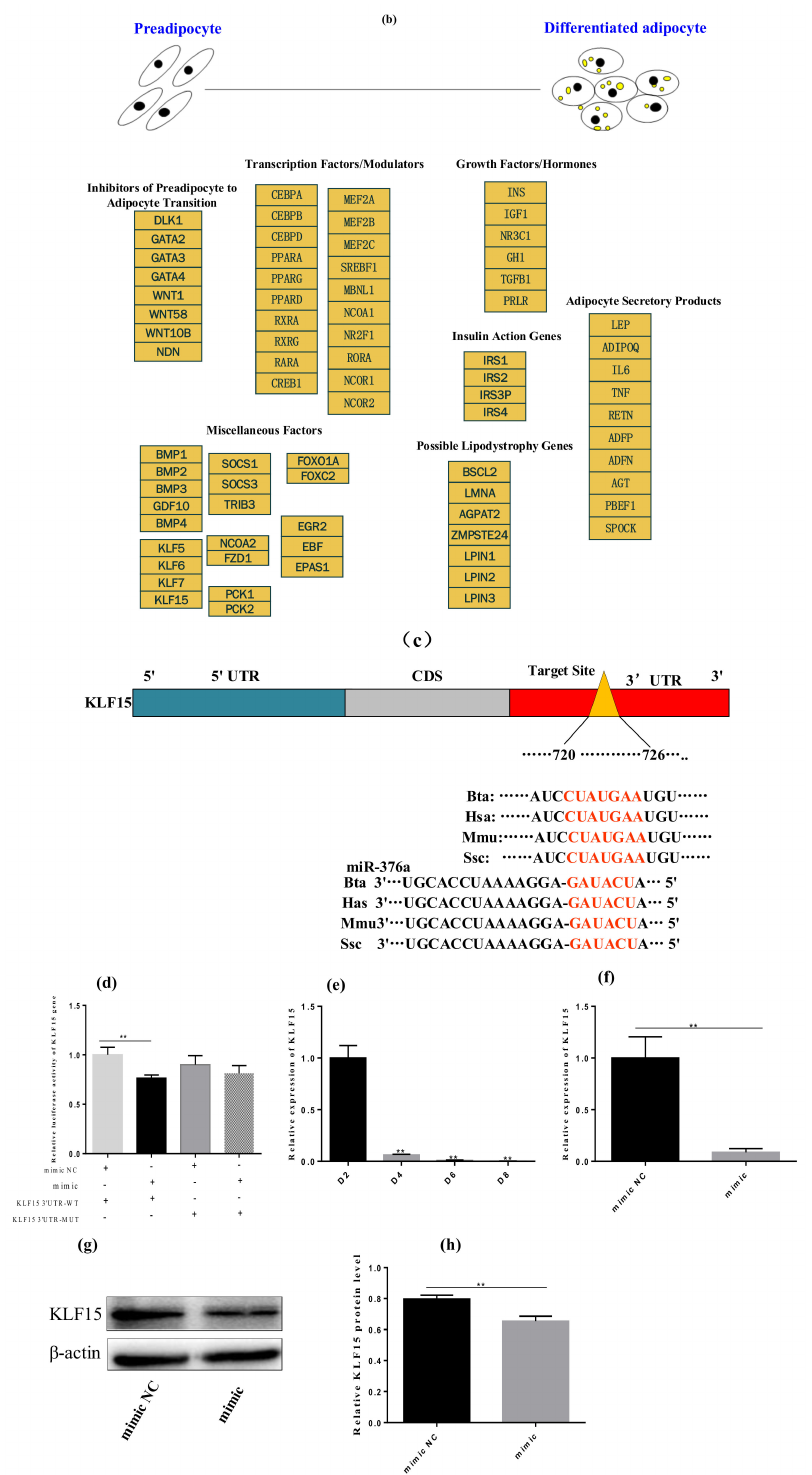
Figure 4. ( a ) KLF15 is a target gene of bta-miR-376a in the di ff erentiation of Qinchuan beef preadipocytes. ( b ) Adipogenesis signaling pathway. ( c ) Sequence alignment of bta-miR-376a in 3 (cid:48) UTR of Bta (cattle), Human (HSA), Mouse (MMU), and Pig (SSC). ( d ) Changes of luciferase activity after co-transfection. ( e ) KLF15 expression during adipogenic di ff erentiation at the mRNA level . ( f ) The relative expression of KLF15 was observed after treatment. ( g ) The expression of KLF15 protein was analyzed by Western blot after transfection of bta-miR-376a mimic and bta-miR-376a mimic NC. ( h ) KLF15 protein level was quantified. Data are expressed as mean ± SEM, ** p ≤